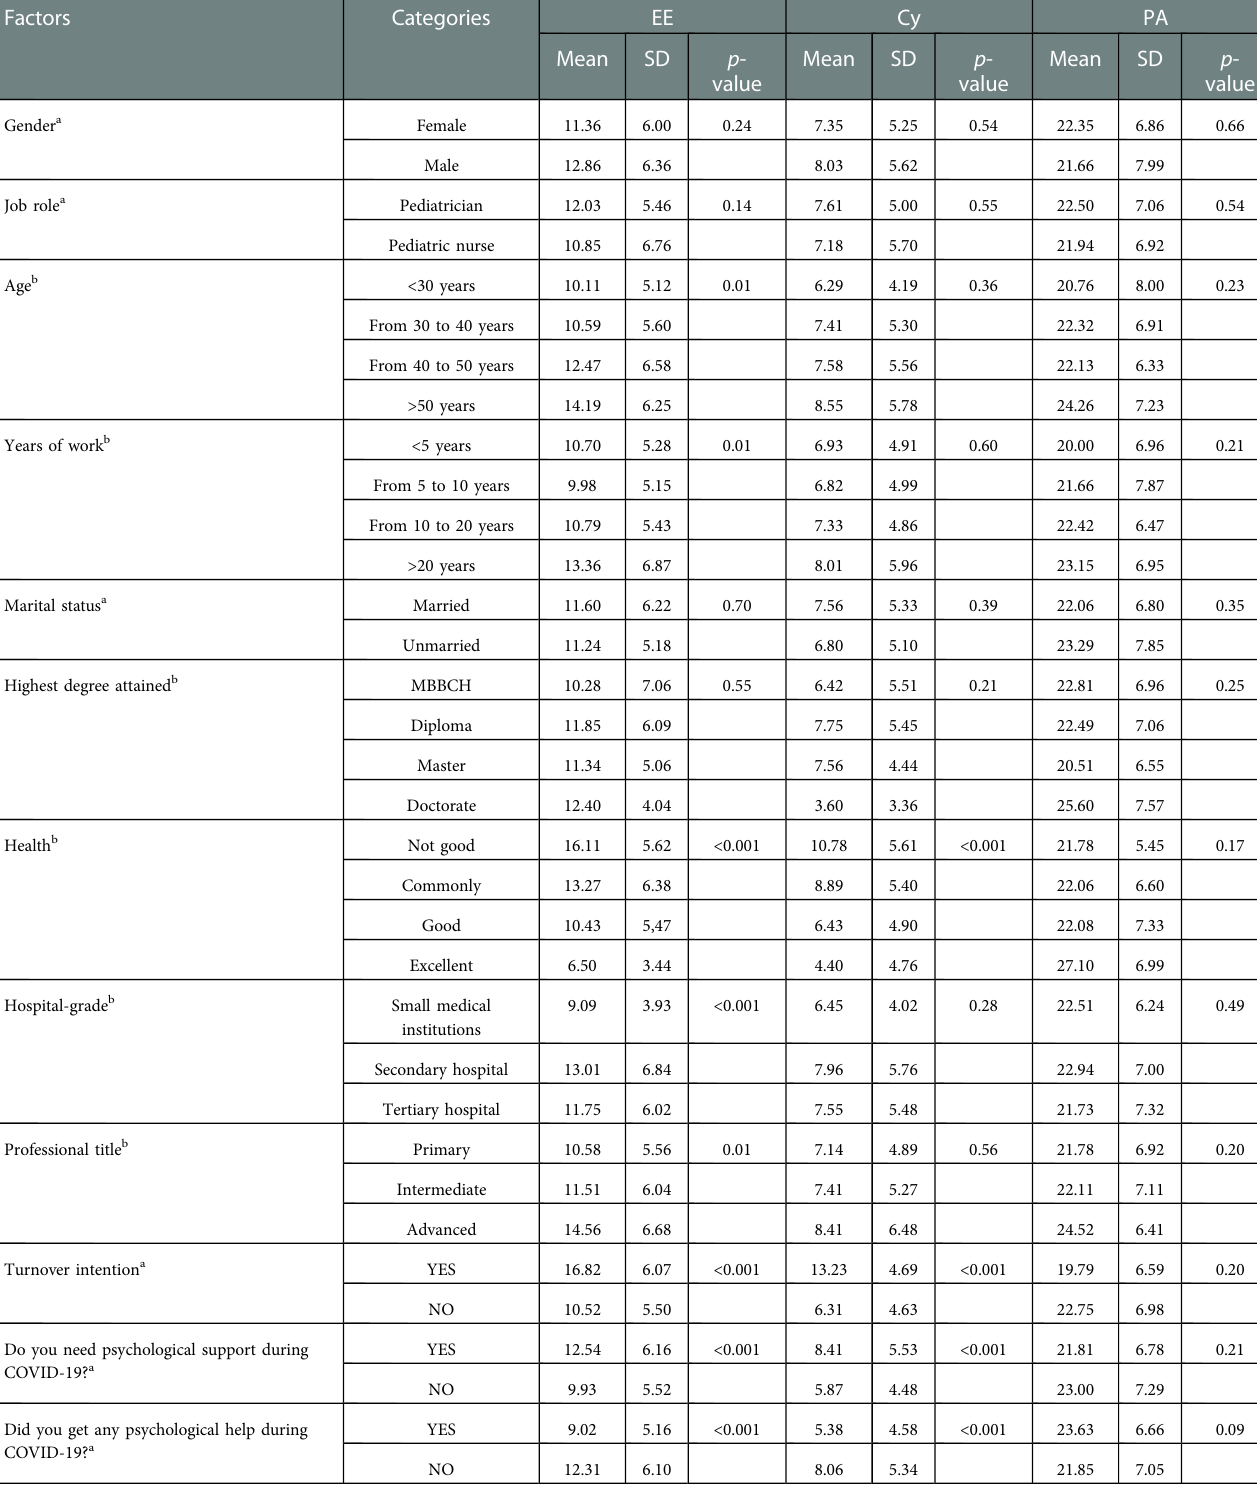
TABLE 3 Association between demographic characteristics and related factors with different BOS domains.